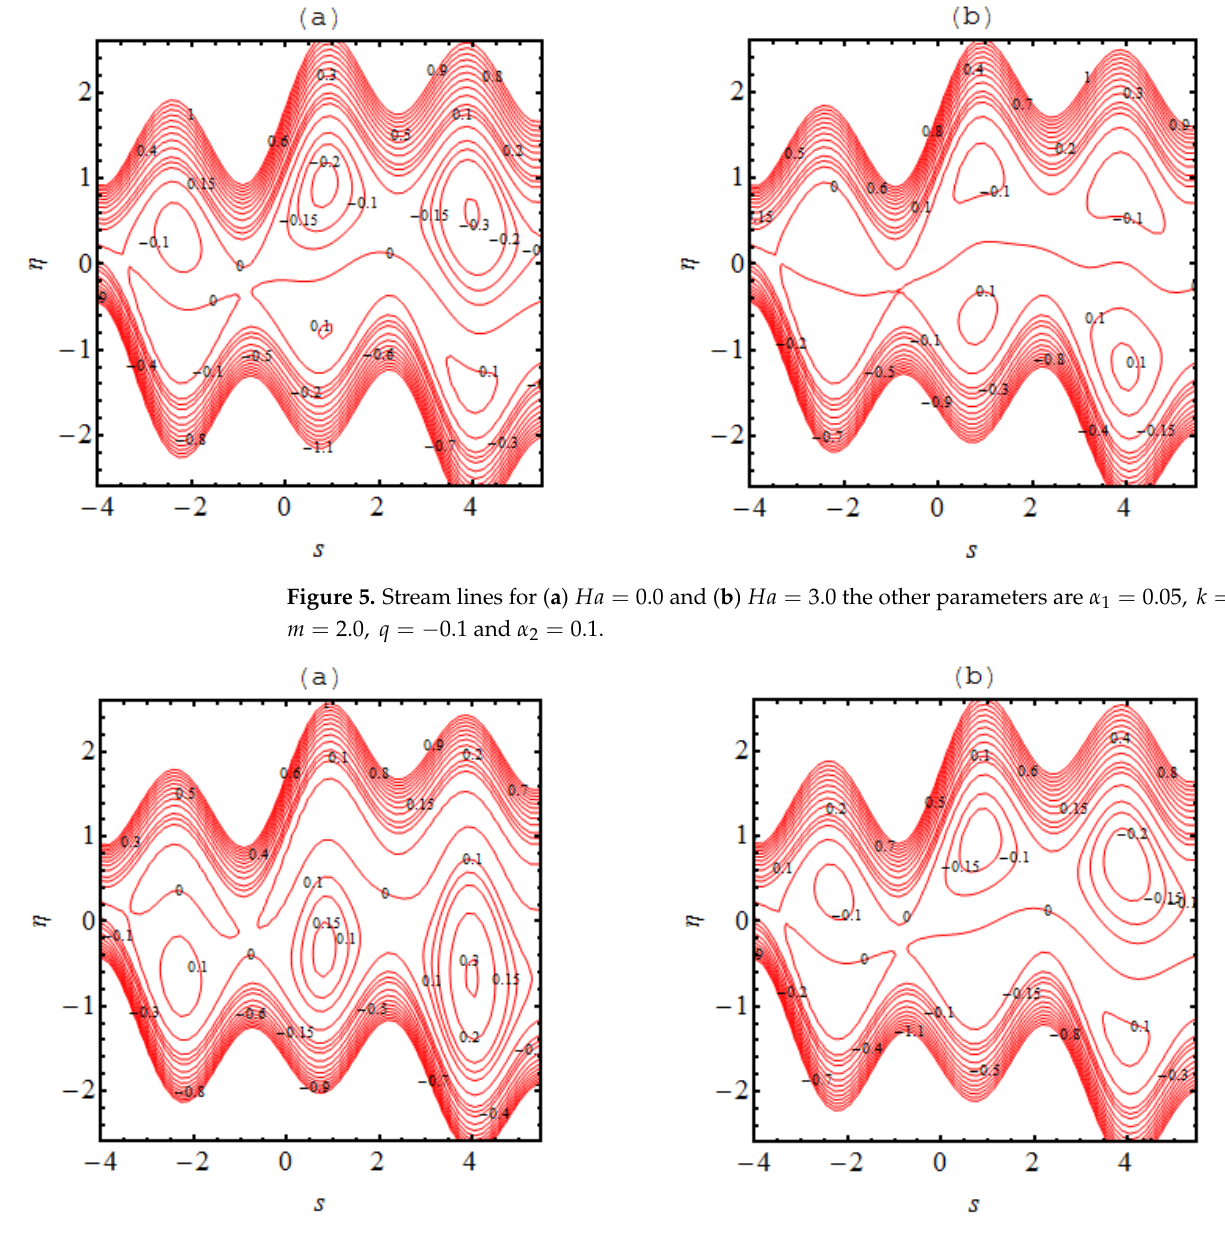
Figure 6. Stream lines for ( a ) m = 0.0 and ( b ) m = 2.0 the other parameters are α 1 = 0.05, k = 3.0, Ha = 3.0, q = − 0.1 and α 2 = 0.1.